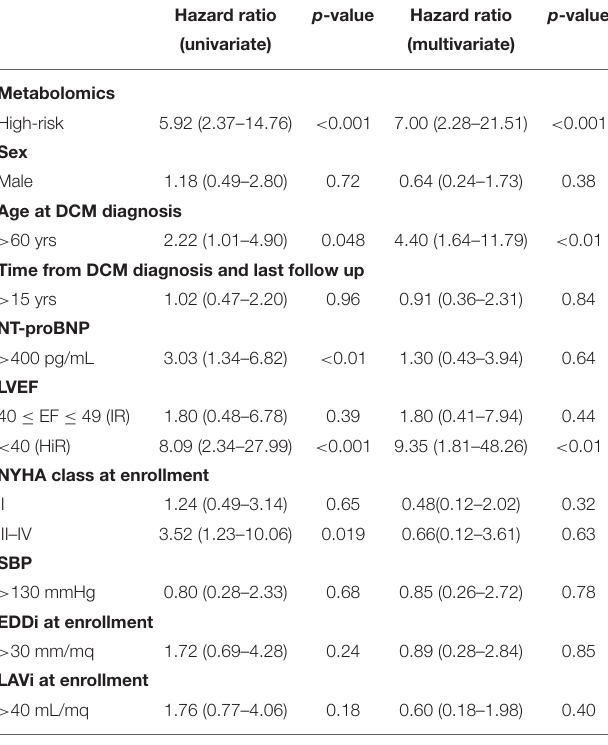
TABLE 2 | Association with the outcome: unadjusted and adjusted hazard ratios